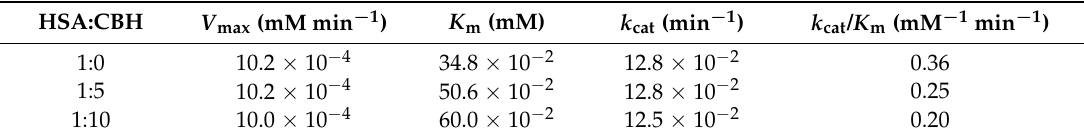
Figure 8. Effect of CBH on the steady-state kinetics of p-NPA hydrolysis by HSA for the hydrolysis of p-NPA by HSA at 25 ◦ C. ( A ) The Michaelis–Menten plot in the absence and presence of CBH. ( B ) Lineweaver–Burk plot for the steady state kinetics of p-NPA hydrolysis by HSA. Table 4. Kinetic parameters describing Michaelis-Menten constant, V max , catalytic constant and catalytic efficiency of HSA in the absence and presence of increasing CBH concentrations.